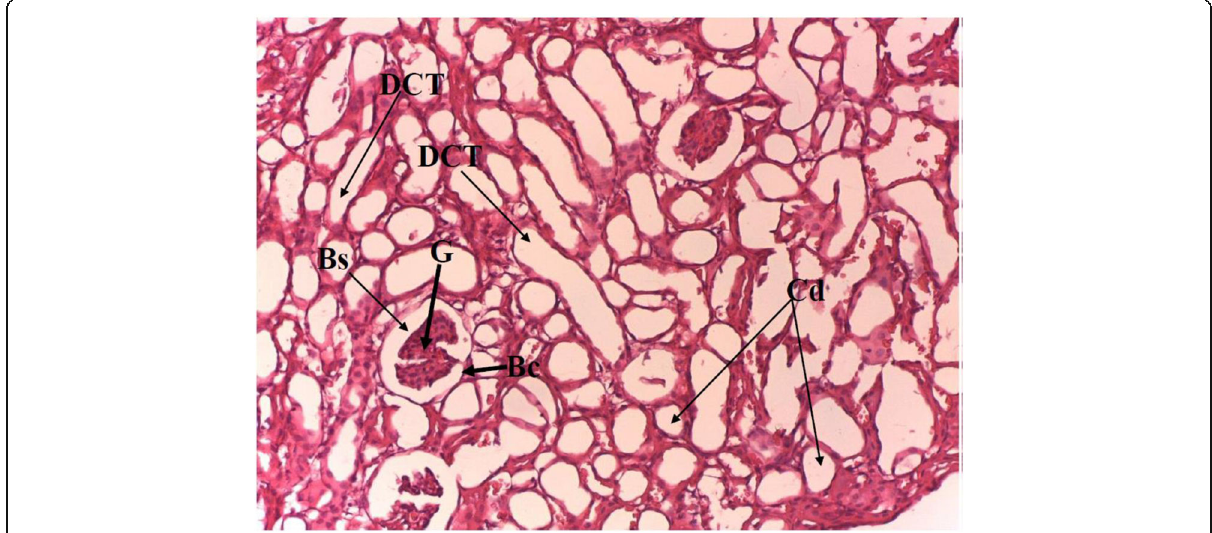
Fig. 8 Photomicrograph of kidney section of normal rat showing normal glomerulus (G), collecting ducts (Cd), Bowman ’ s space (Bs), Bowman ’ s capsule (Bc) and distal convoluted tubule (DCT)